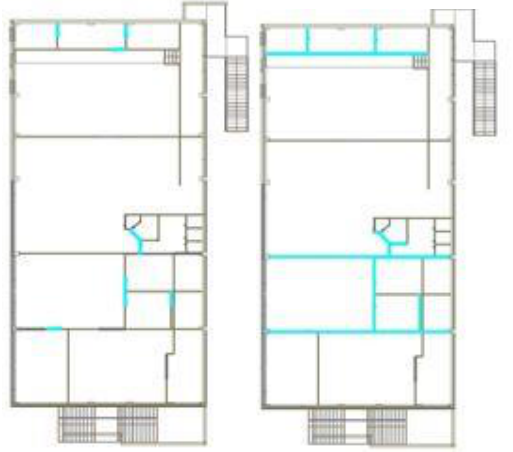
Figure 6 : the result of the query in textual